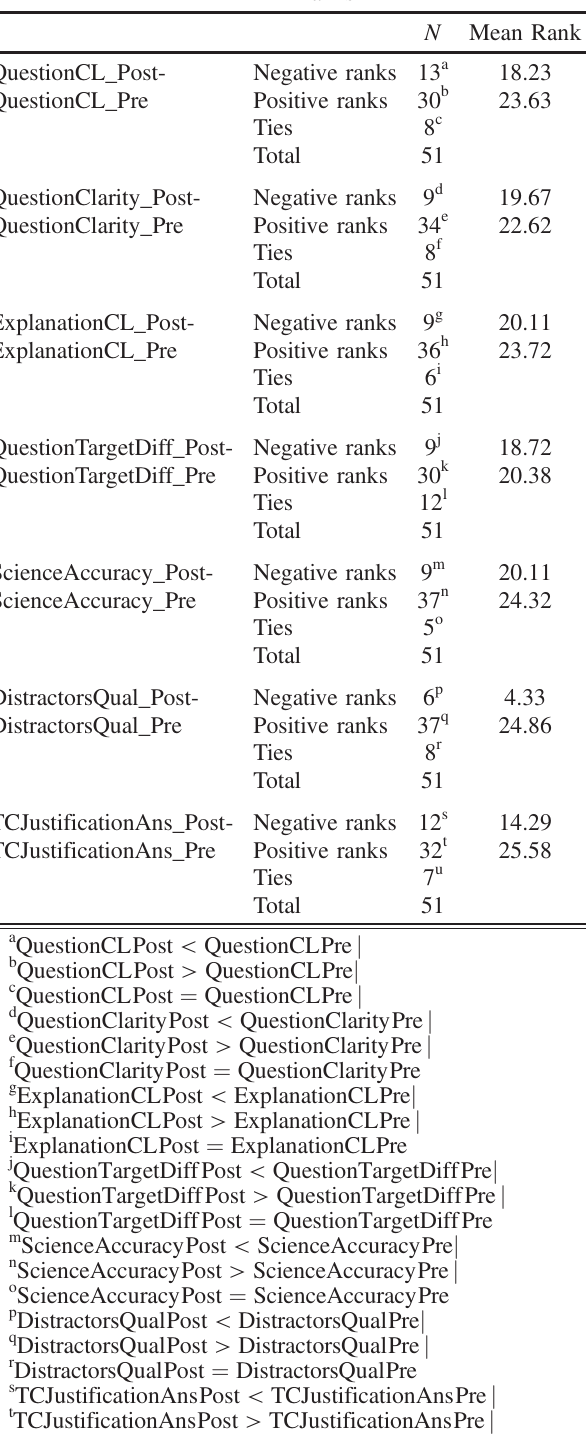
TABLE V. Wilcoxon signed ranks tests (two related samples). Ranks Test Statistics N Mean Rank Sum of Ranks Z Asymp. Sig. (2-tailed)